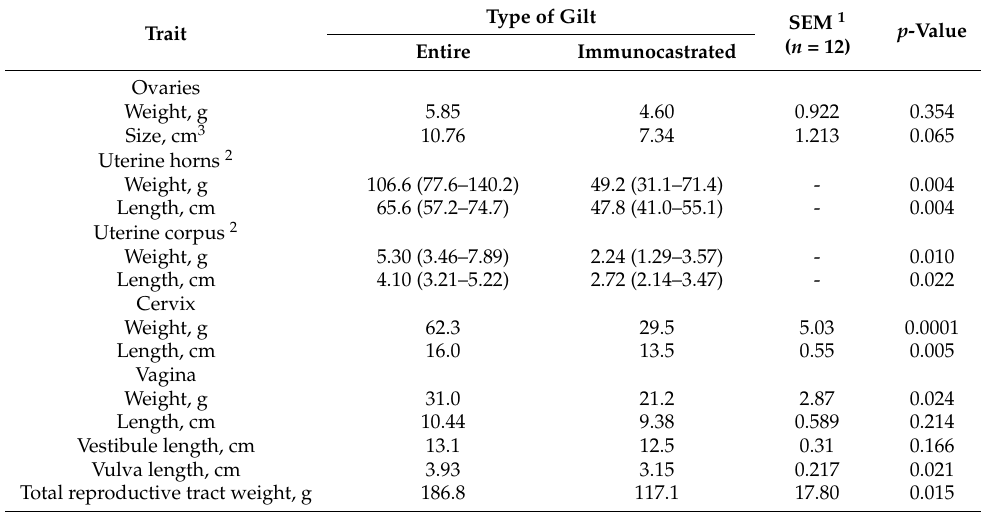
Table 5. Impact of immunocastration on reproductive organs (least square means) of heavy